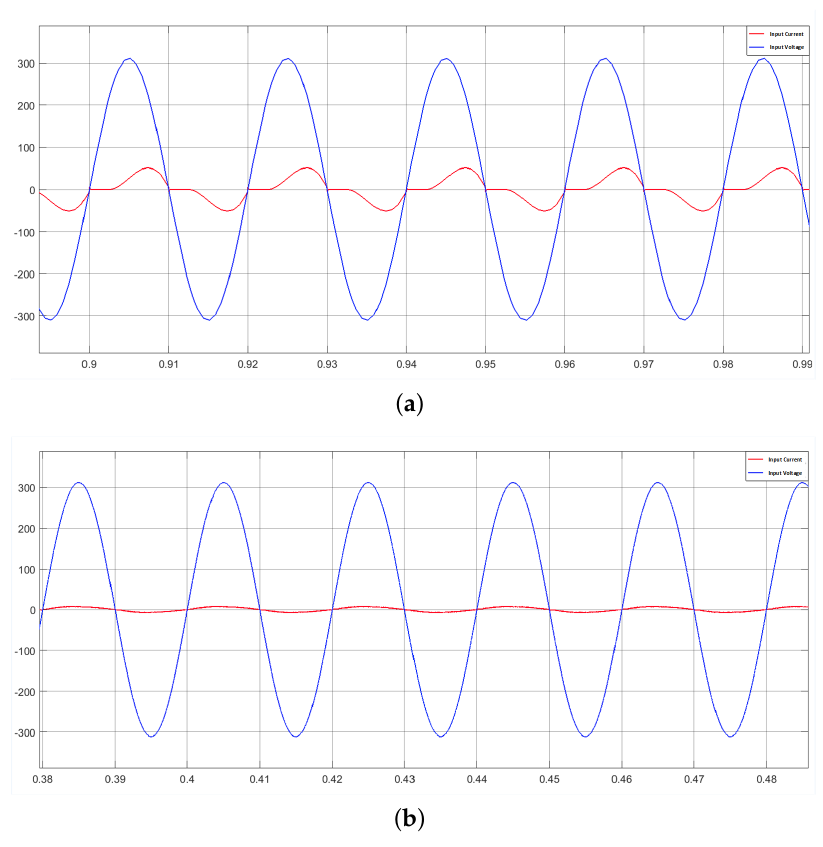
Figure 10. The simulation result of PFC. ( a ) Waveform without PFC. ( b ) Waveform without PFC. The PFC output voltage fluctuates around 390 V, as shown in Figure